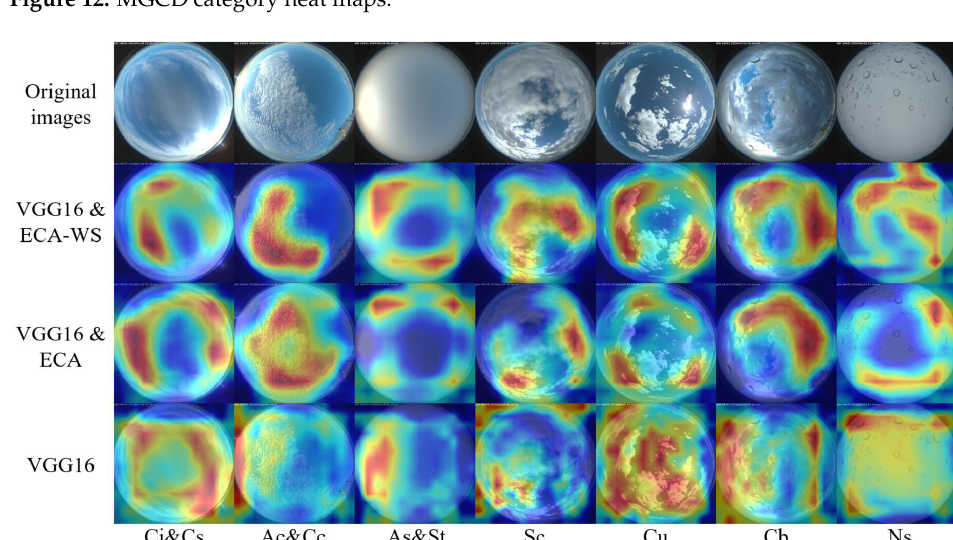
Figure 12. MGCD category heat maps.